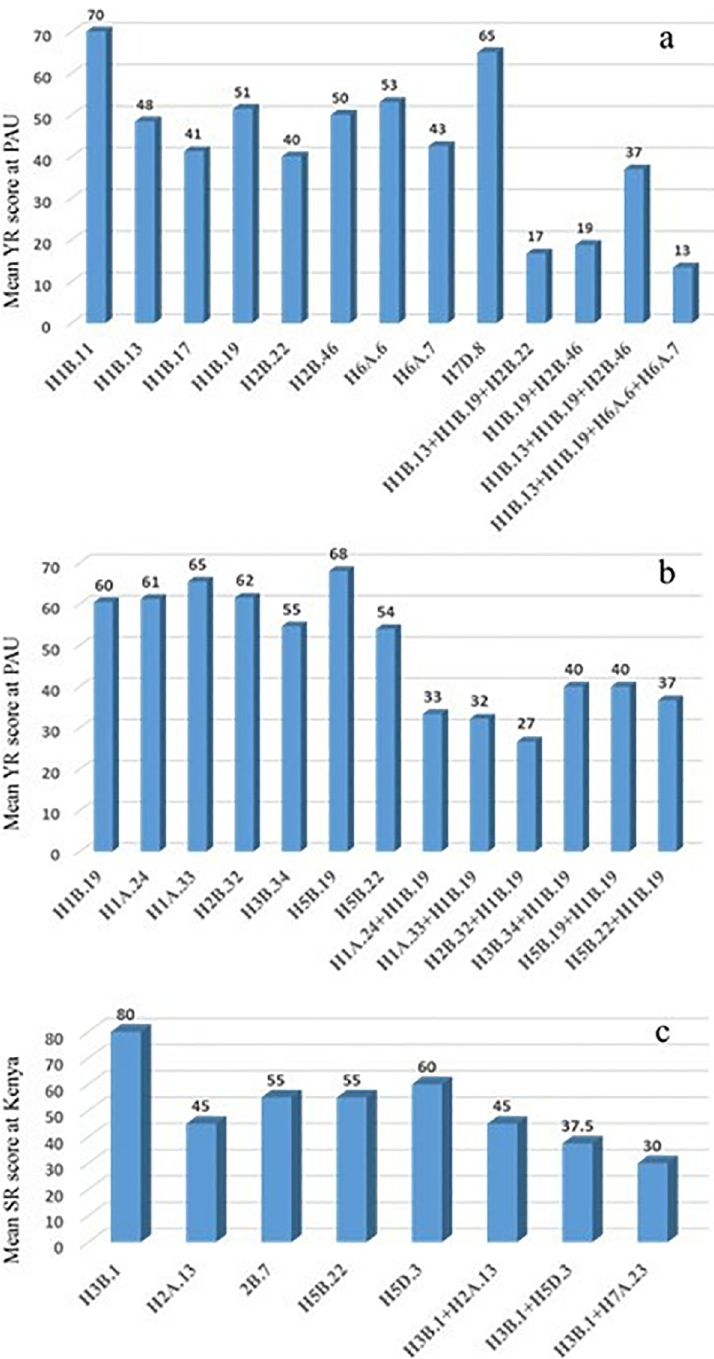
Fig 10. Individual QTL-QTL combination effects on mean YR at PAU (a) and Toluca (b) environments and on mean SR resistance (c) at Kenya. Haplotype(s) H1B.19 or a combination of H1B.13 and H1B.19 was used to represent additive QTL effects for YR resistance- associated loci, whereas haplotype H3B.1 is used to show additive effects for SR resistance-associated loci.